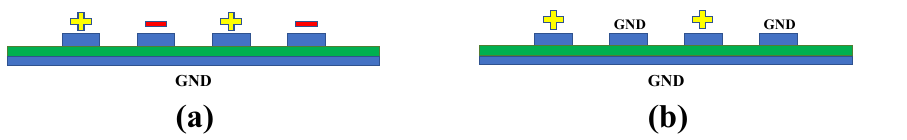
Figure 7. Block-level diagram of a possible integrated detection system.